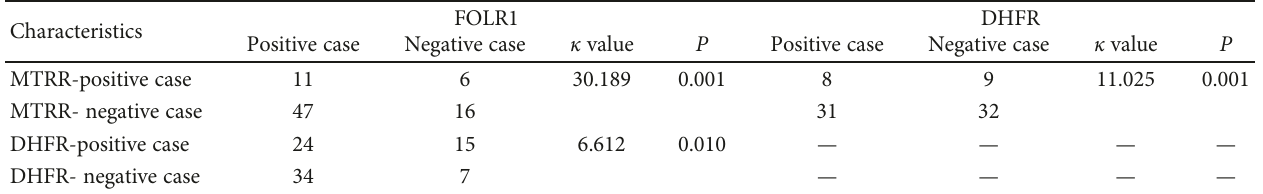
Table 4: The relation among FOLR1, DHFR, and MTRR expression in ovarian cancer. Characteristics